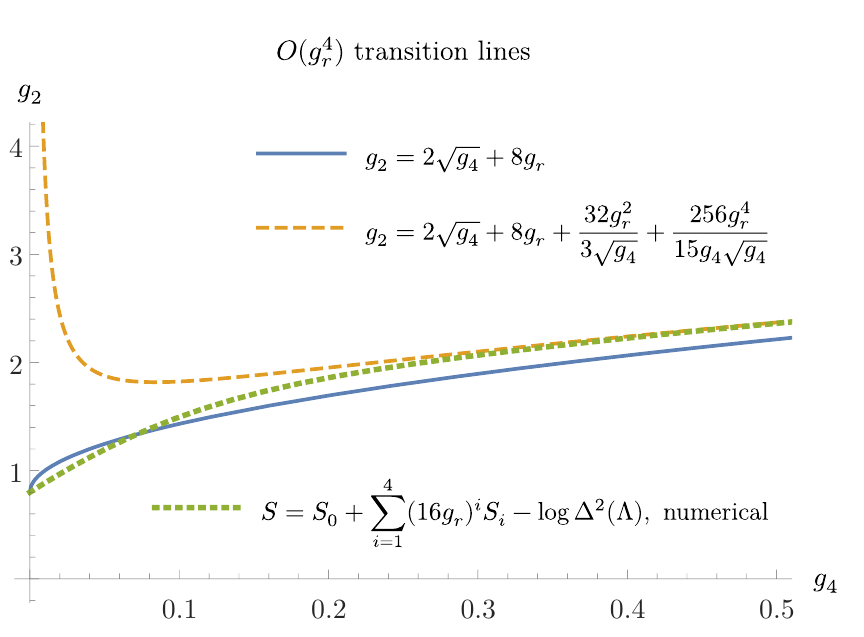
Figure 2 . Blue solid line represents O ( g r ) correction from (4.8). Orange dashed line represents ) transition line (4.10). Green dotted line represents numerically calculated transition line for O ( g 4 r the multitrace model (3.20) (see appendix D). All three plots are for g